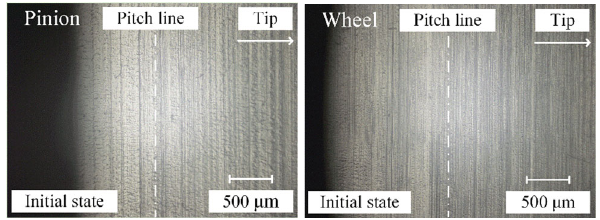
Fig. 7 Initial topography states of the test gears.